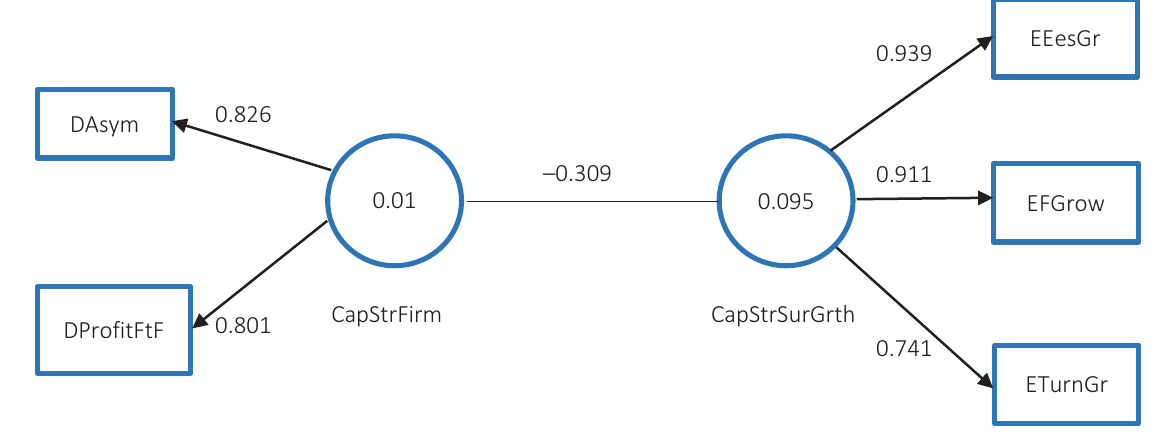
Figure 4. Empirical results of the research